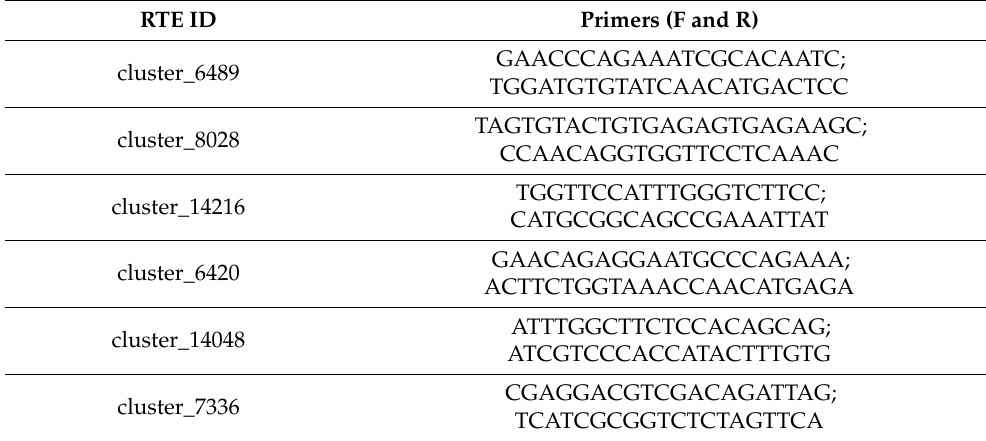
Table 1. Primers used for eccDNA